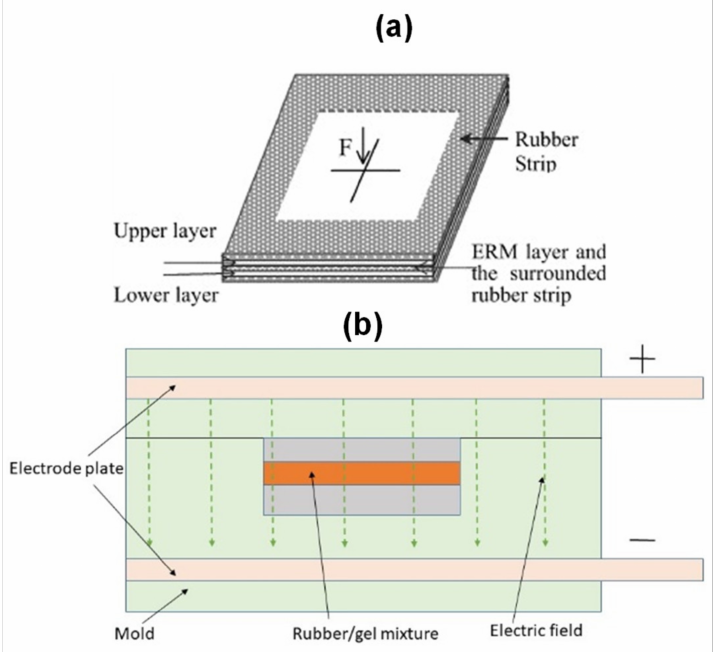
Figure 15. ( a ) Electrorheological fluid (ERF) sandwich beam [103]; ( b ) Electrorheological elastomer (ERE) sandwich